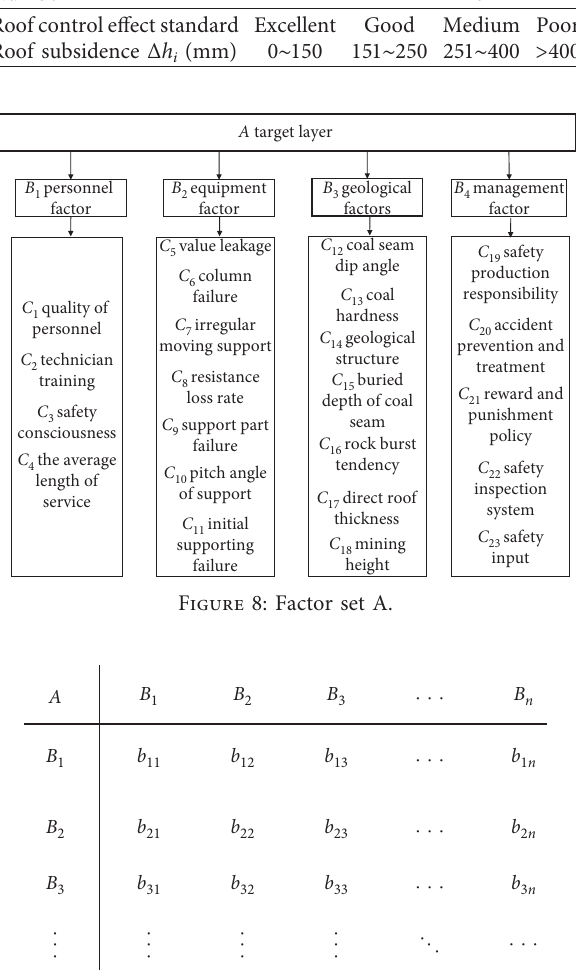
Table 3: Roof control effect standard of 103 working face. Number